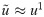
Learning in Willshaw-type associative networks.
A, Memory storage by Hebbian weight plasticity (Eq. 5) in a fully connected network (P = 1). Address patterns u
μ are associated to content patterns v
μ where μ = 1,…,M (here M = 2). Each memory is represented by a binary activity vector of length n = 7 having k = 4 active units (which define the corresponding cell assembly). B, One-step retrieval of the first memory from a noisy query pattern u˜≈u1 having two of the four active units in u
1 (λ = 0.5). Here u˜≈u1 can perfectly reactivate the corresponding memory pattern in population v (v^=v1) applying a firing threshold Θ=∑iu˜i=2 on dendritic potentials xj=∑i=1mWiju˜i. C, As a simple form of structural plasticity, silent synapses can be pruned after learning. The resulting network has only 28 (instead of 49) synapses corresponding to a lower anatomical connectivity P ≈ 0.57, whereas the effectual connectivity is still P
eff = 1. Thus, pruning does not change network function, but increases stored information per synapse. D, Ongoing structural plasticity can similarly increase storage capacity during more realistic learning in networks with low anatomical connectivity (here P = 28/49 ≈ 0.57). During each time step t = 1, 2, 3, 4, Hebbian weight plasticity potentiates and consolidates synapses ij with non-zero consolidation signal S
ij > 0 (which equals W
ij of panel A), whereas the remaining silent synapses are eliminated and replaced by new synapses at random locations. Note that the resulting network at t = 4 is the same as in panel C.